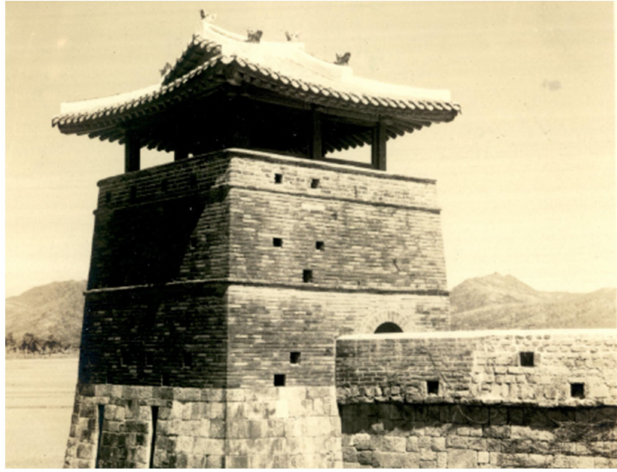
Figure 11. Gongsimdon Tower in the Hwaseong City Wall. Hwaseong City Walls, n.d. Reprinted with permission from Ref. [46]. n.d, National Institute of Korean